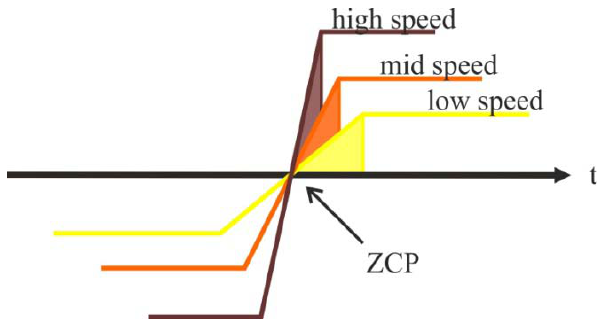
Figure 11. Integrated areas of the back-EMF